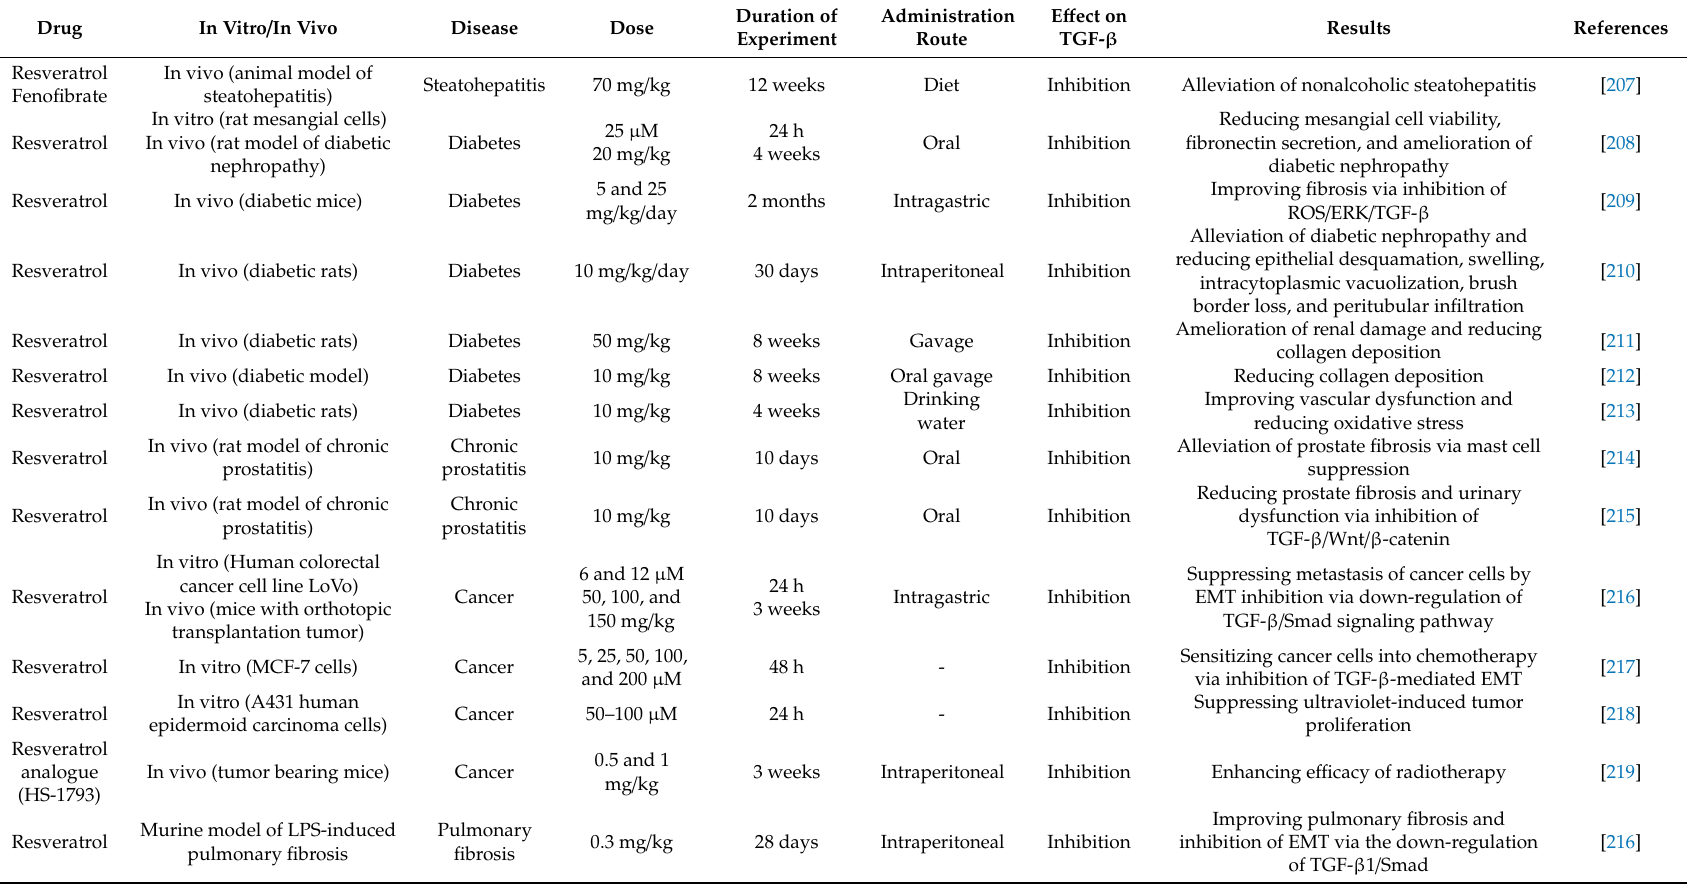
Table 1. Res targets TGF- β signaling pathway in disease